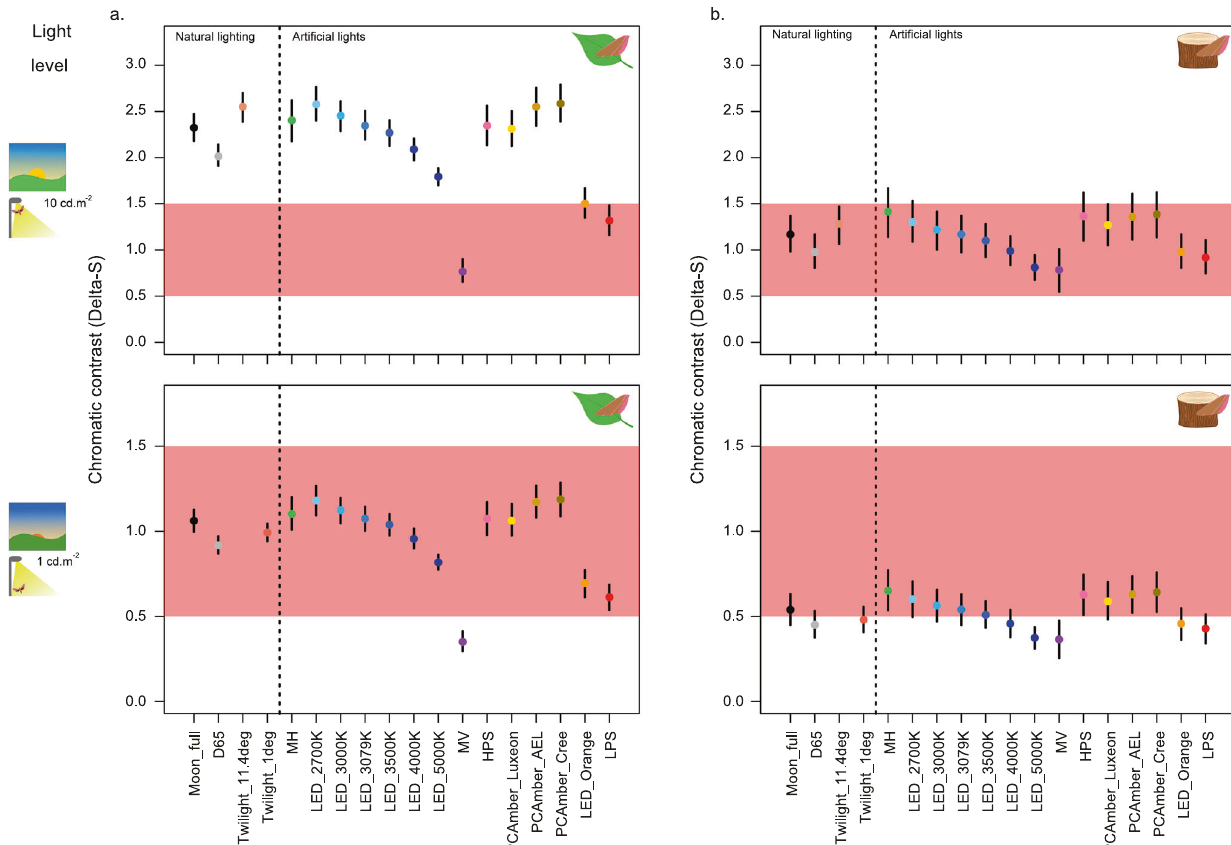
Fig. 3 Moth-background colour discrimination for birds under arti fi cial light. Bootstrapped estimates of the distance (in Delta-S) between the geometric means of moth forewing colours (N moths = 235) and background colours (N green = 871, (N brown = 274), in the blue tit RNL chromaticity space. Mean and 95% con fi dence intervals are shown for green ( a ) and brown ( b ) natural backgrounds, under two light levels (10 and 1 cd m − 2 , from top to bottom, represented by cliparts on the left-hand side), based on 1000 bootstrapped replicates per comparison. Each light type is represented by a different colour. The coloured bands represent putative thresholds for colour discrimination (Delta-S between 0.5 and 1.5). Source data are provided as a Source Data fi